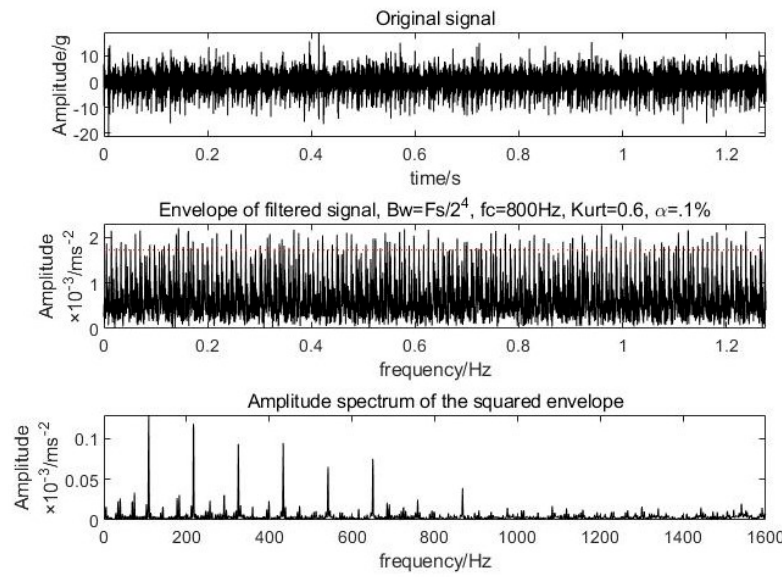
Figure 12. Fast Spectral Kurtosis Processing Results.